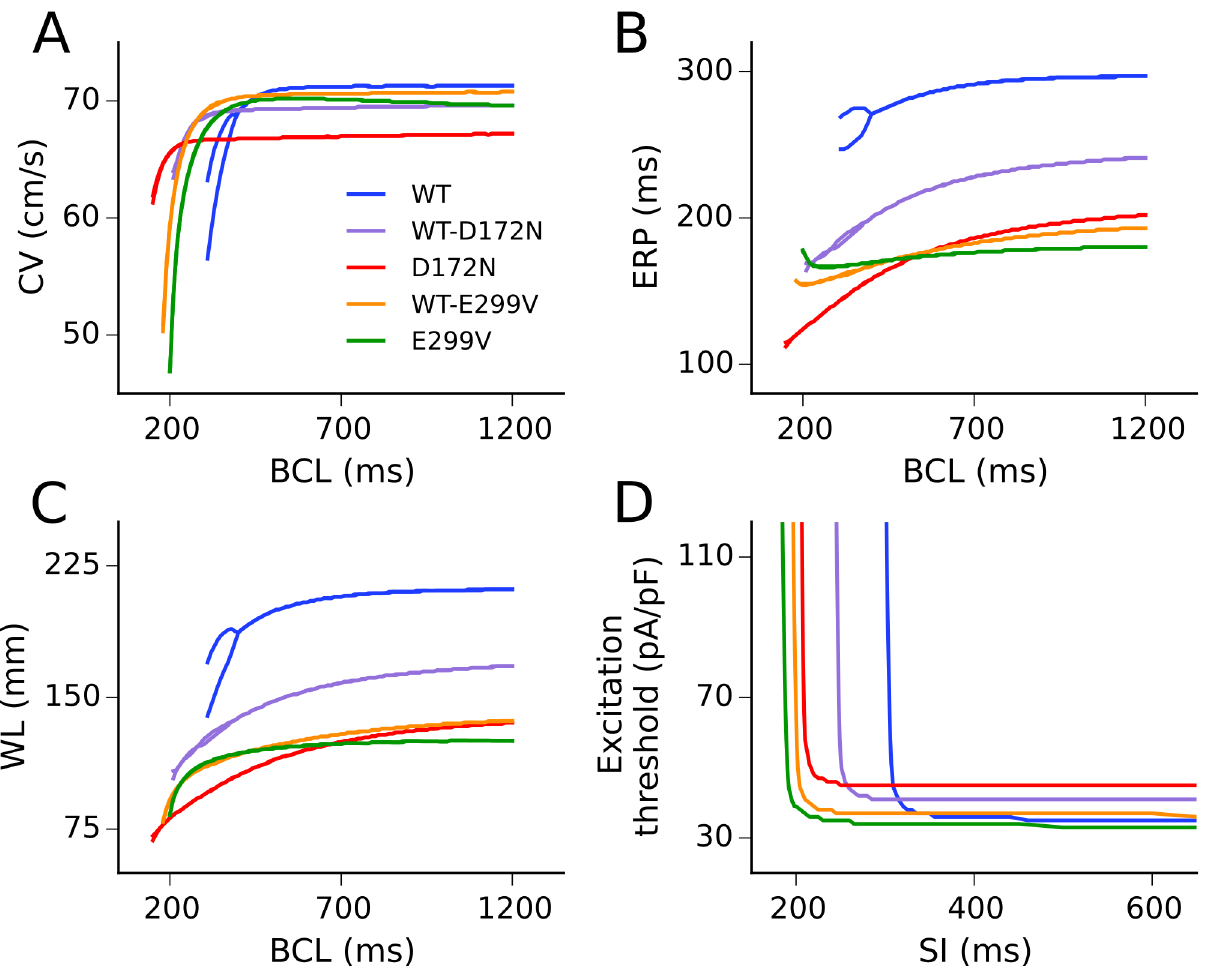
Fig 5. Tissue restitution properties in WT and mutation conditions. Restitution of the CV (A), ERP (B), and WL of re-entry (C) againsta range of basic cycle lengths(BCL), and excitationthreshold(D) against a range of S1-S2 stimulus intervals (SI), as measuredin the 1D tissue